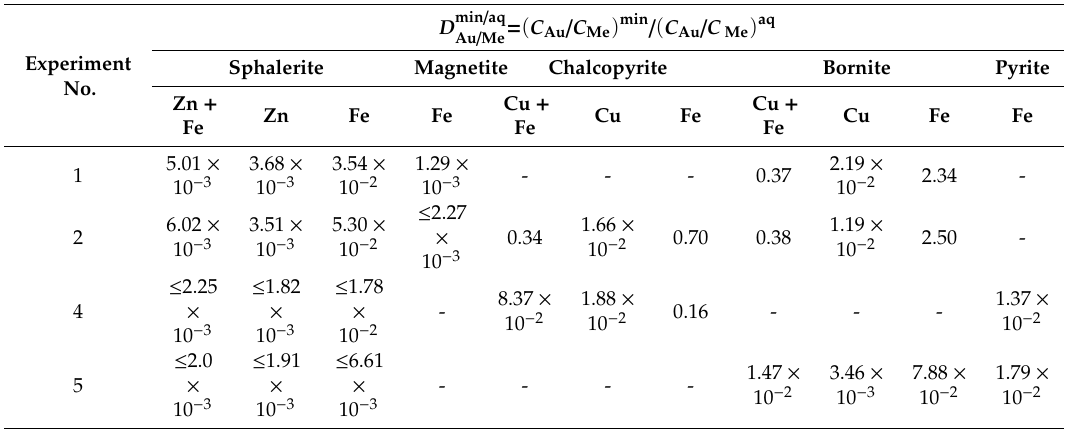
Table 4. Gold / metal cocrystallization coe ffi cients in the mineral-aqueous fluid system at 450 ◦ C and 1 kbar.